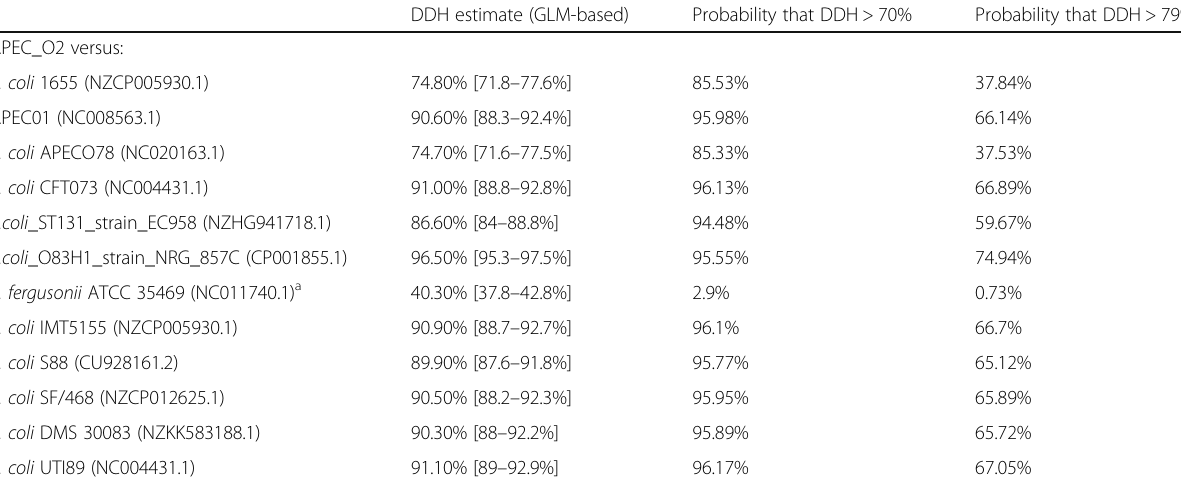
Table 6 DNA:DNA-hybridization (dDDH) of APEC_O2 to selected E. coli strains DDH estimate (GLM-based)